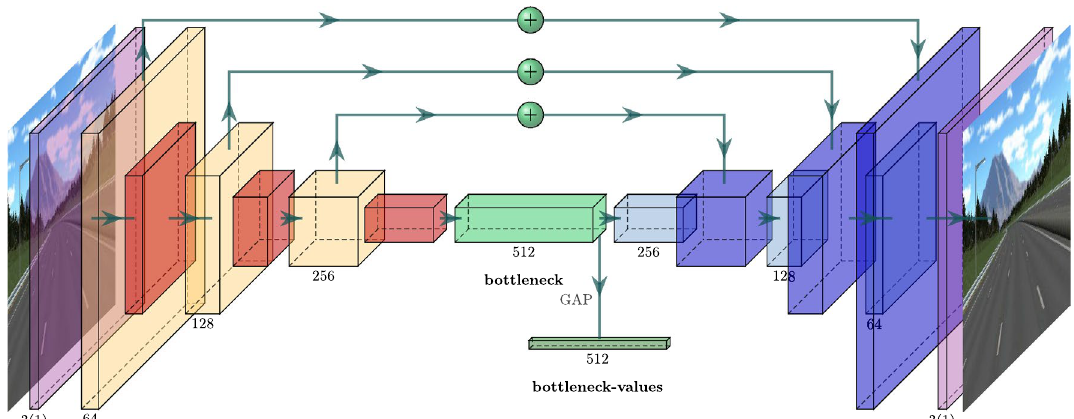
Fig. 4 Architecture of the autoencoder used in the